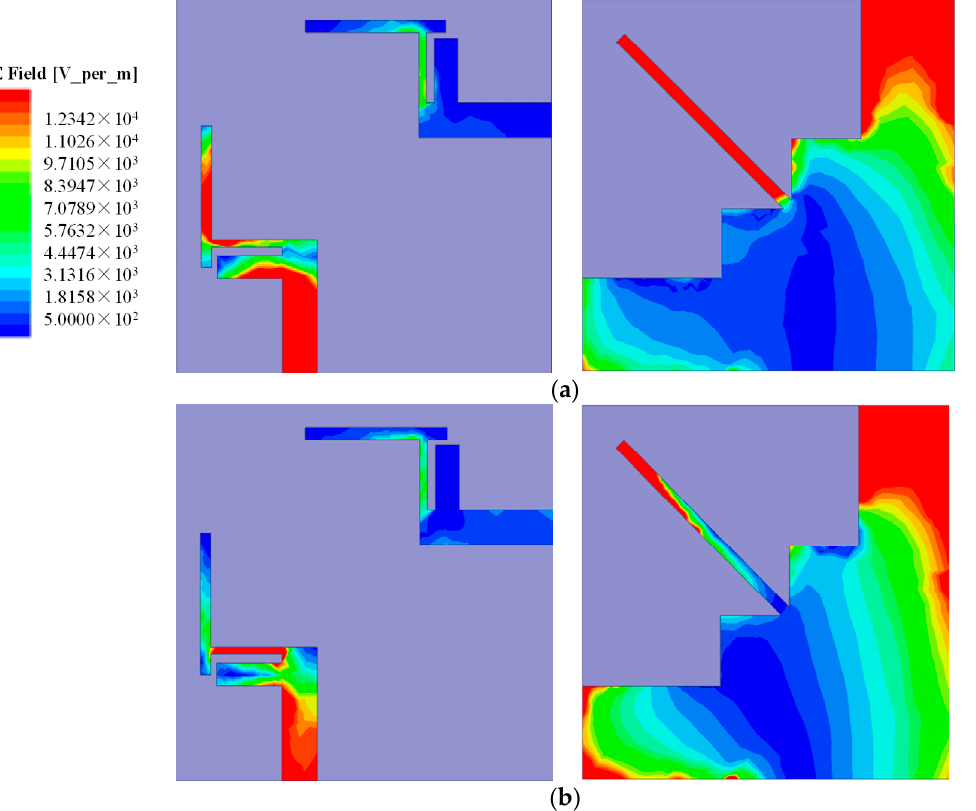
Figure 3. Surface current distributions at ( a ) 2.475 GHz; ( b ) 3.47 GHz.